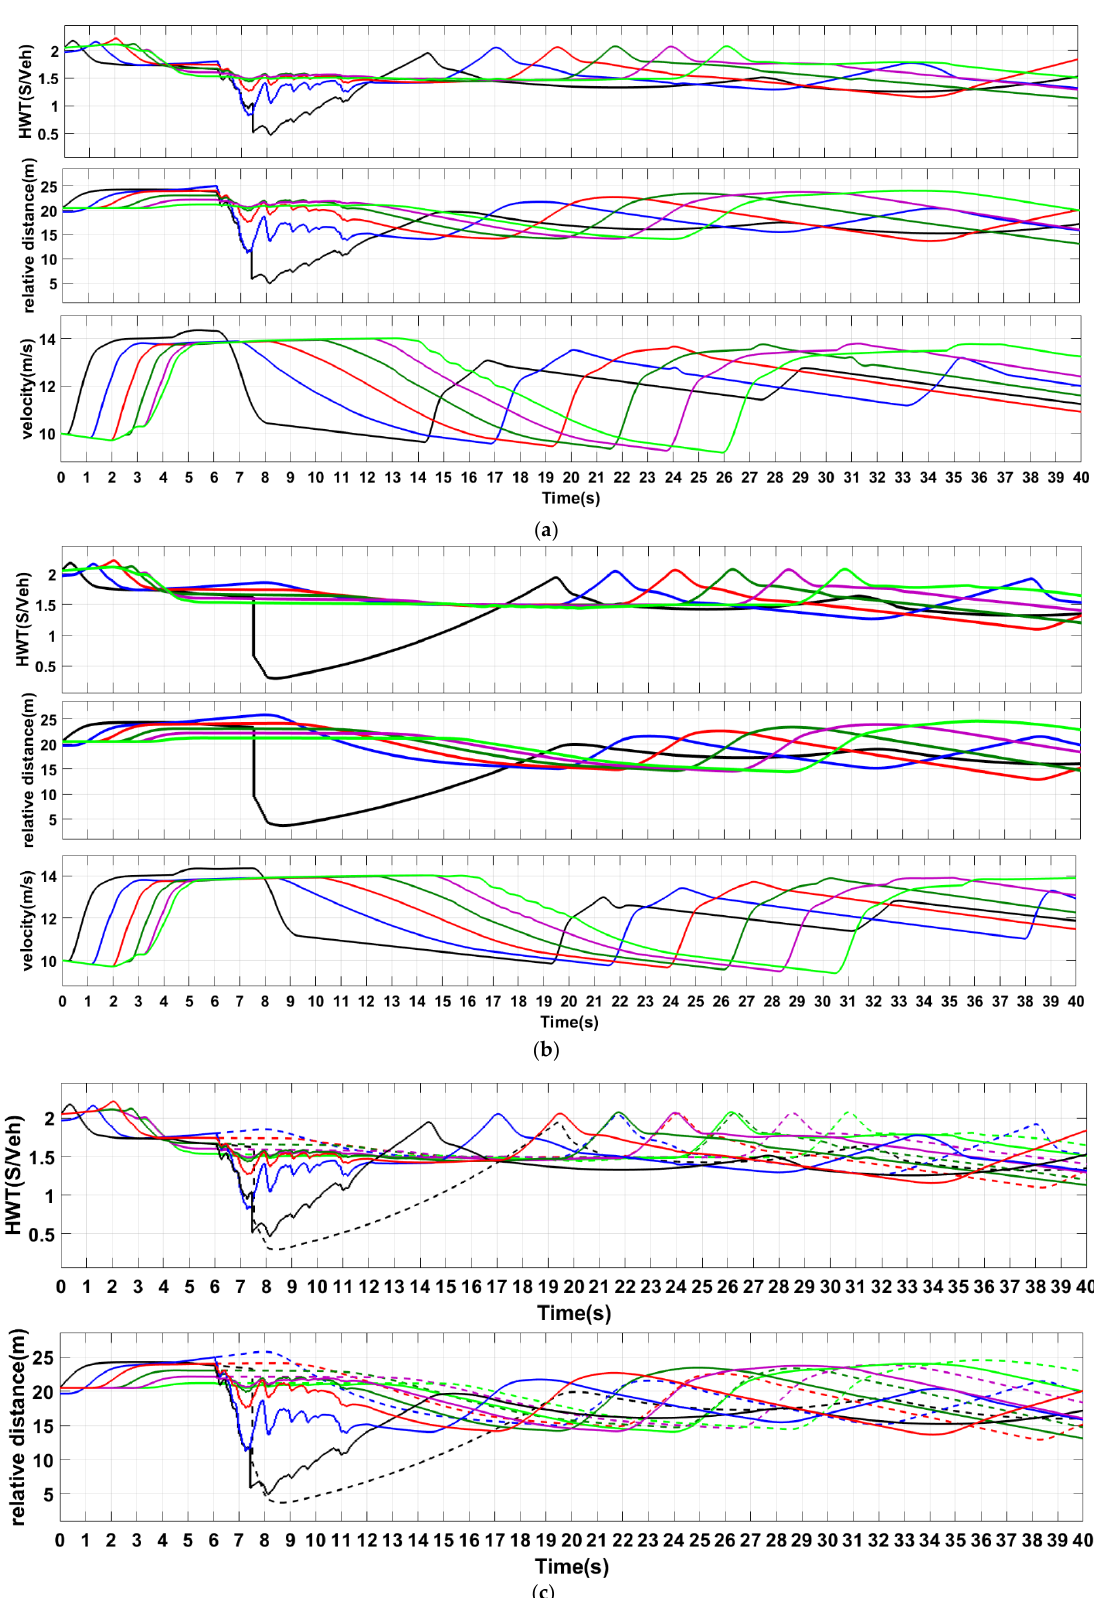
Figure 17. Simulation curve of CAVF fleet and CACCNF fleet in scenario 4: ( a ) CAVF fleet — HWT following distance speed; ( b ) CACCNF fleet — HWT following distance speed; ( c ) comparison of follow-up distance and HWT of CAVF and CACCNF team fleet over 0 – 40 s.